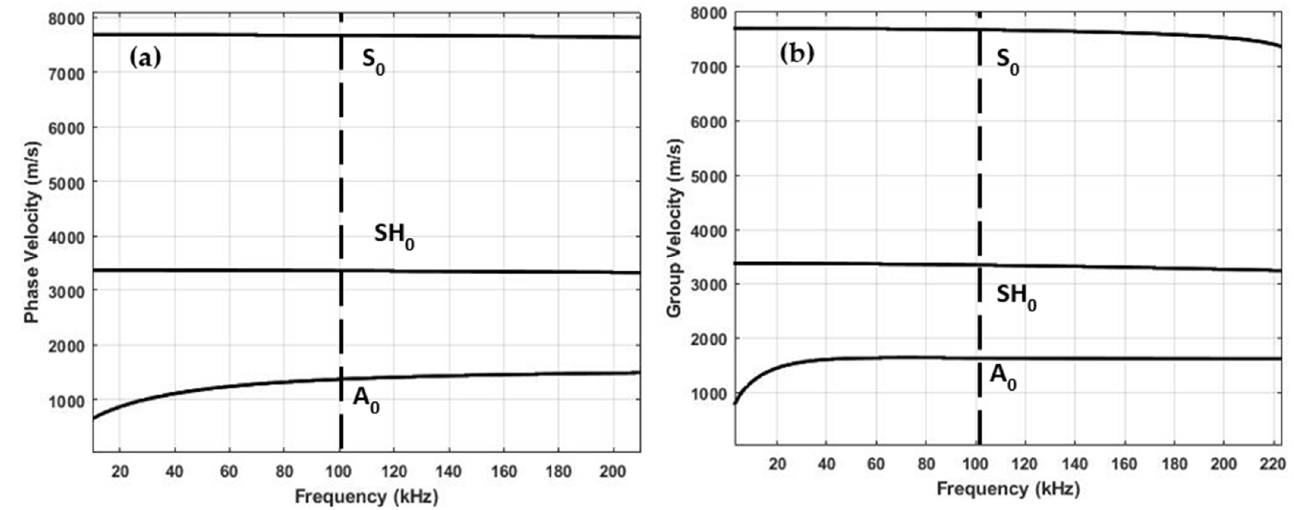
Figure 2. Guided wave dispersion curves in CFRP panel (USN150B): ( a ) phase velocity versus frequency and ( b ) group velocity versus frequency.